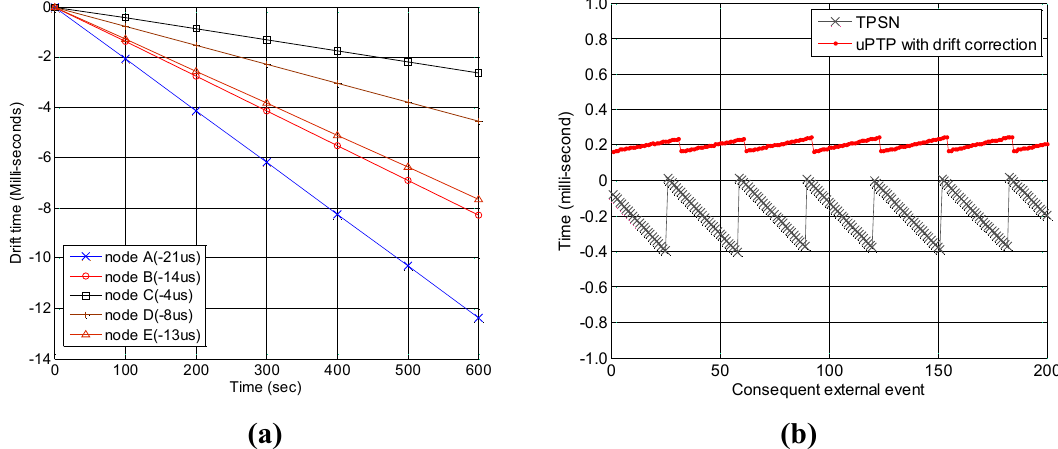
Figure 14. Analysis of clock drift of sensor nodes from sink node. (a) clock drift rate of sensor nodes; (b) clock offset vs. time